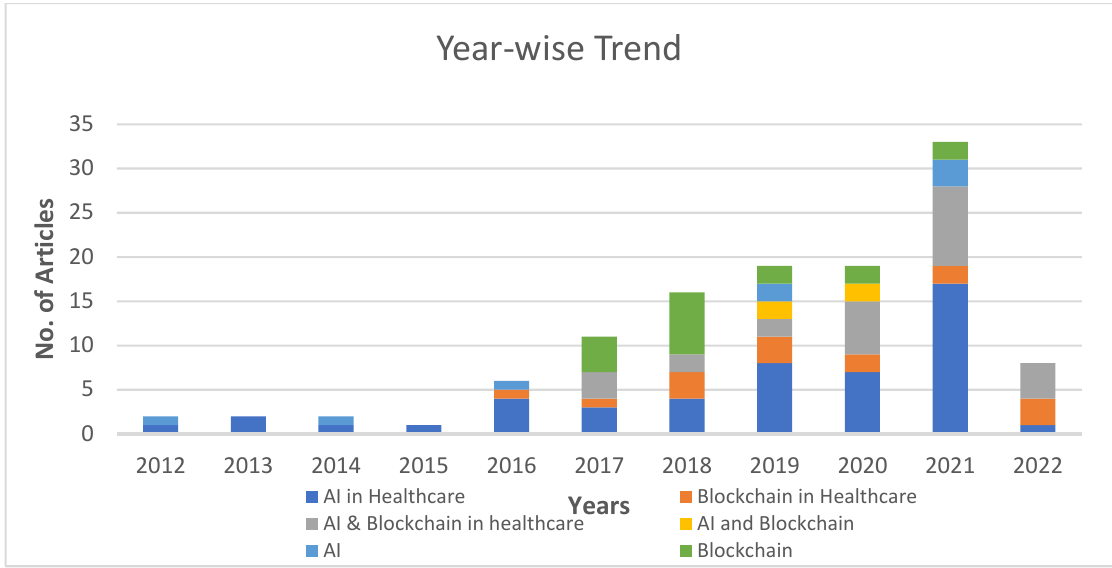
Figure 4. Time graph — number and year of publications studied in this review.